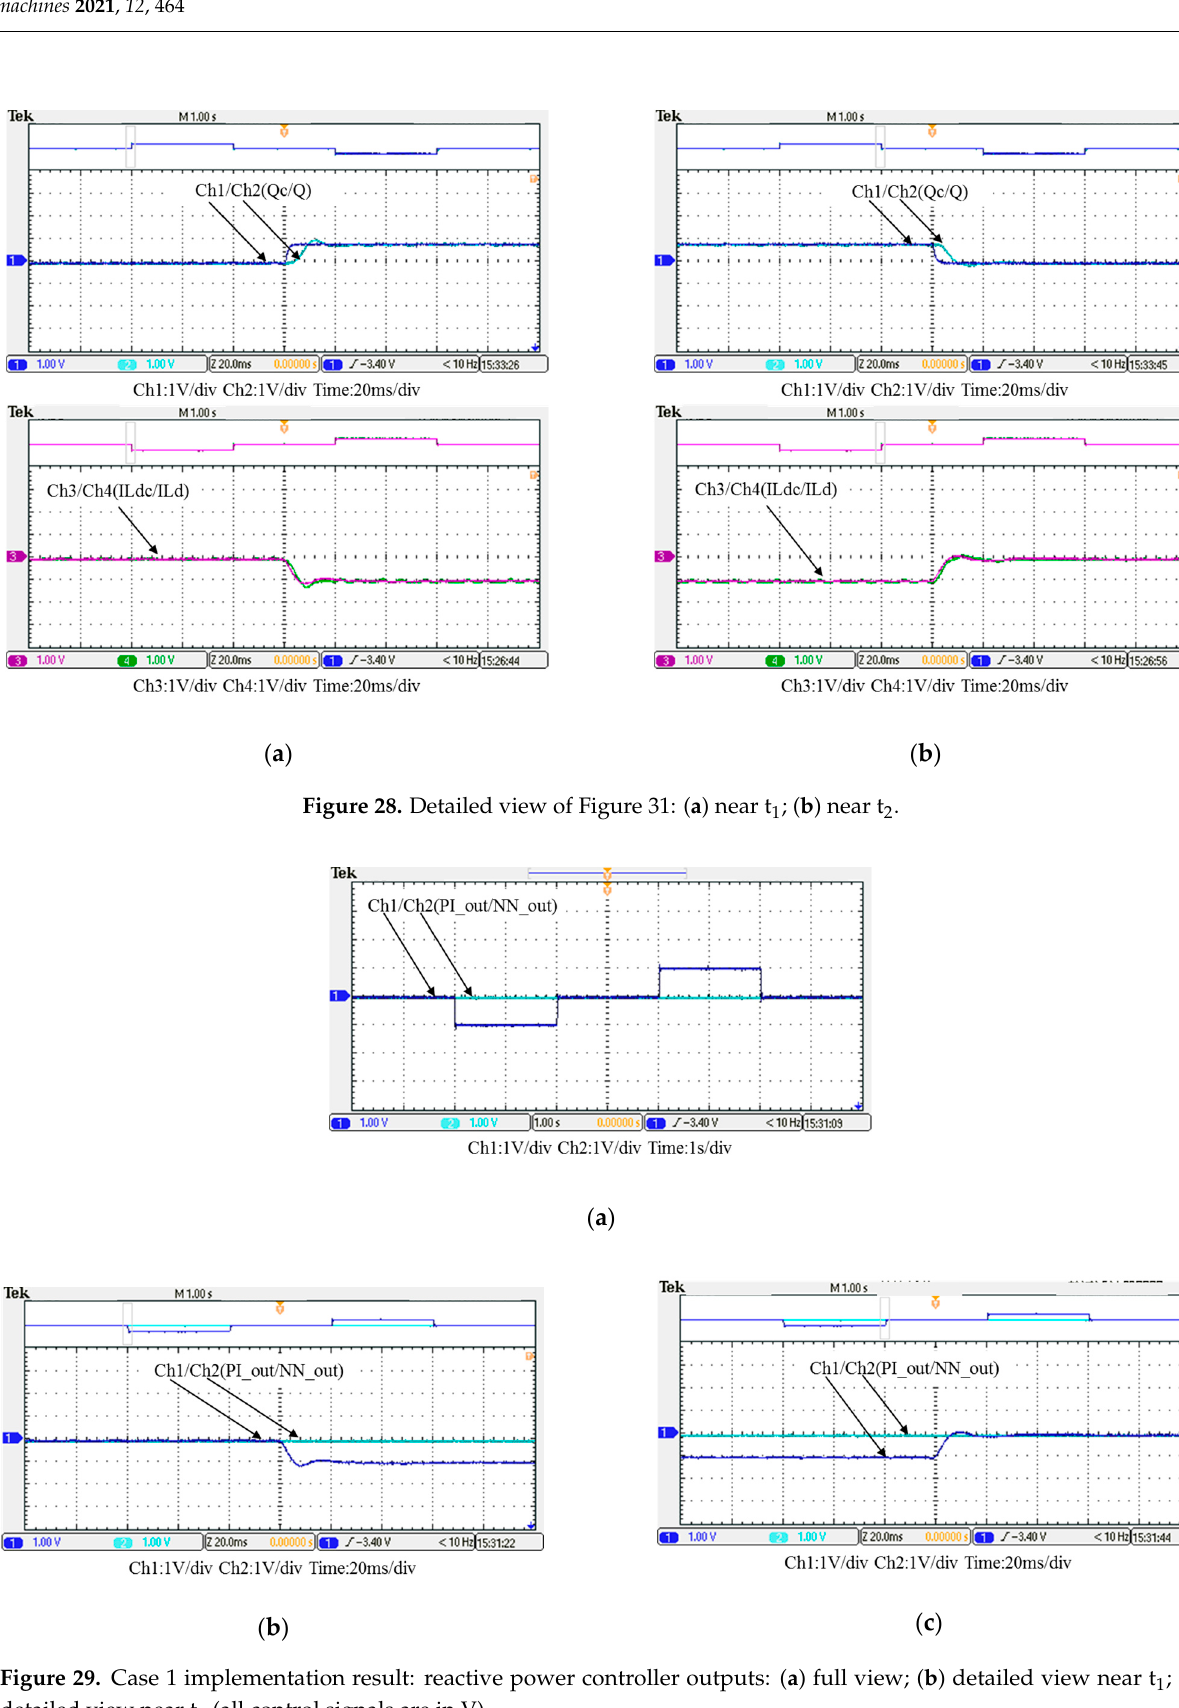
Figure 27. Case 1 implementation result: feedbacks and commands of reactive power and inductor current (all control signals are in V).